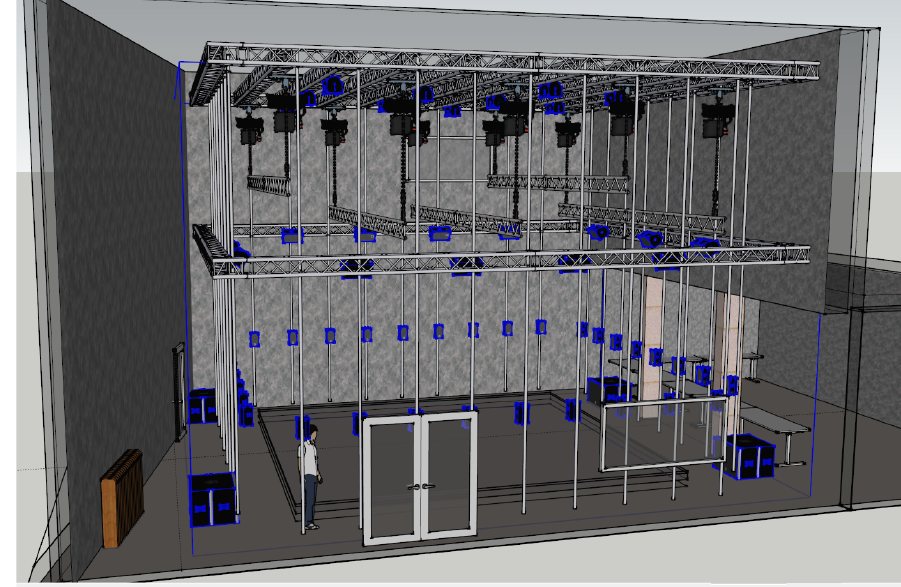
Figure 2. Schematic of the Art-Science-Interaction Lab (ASIL). Speakers are accentuated in